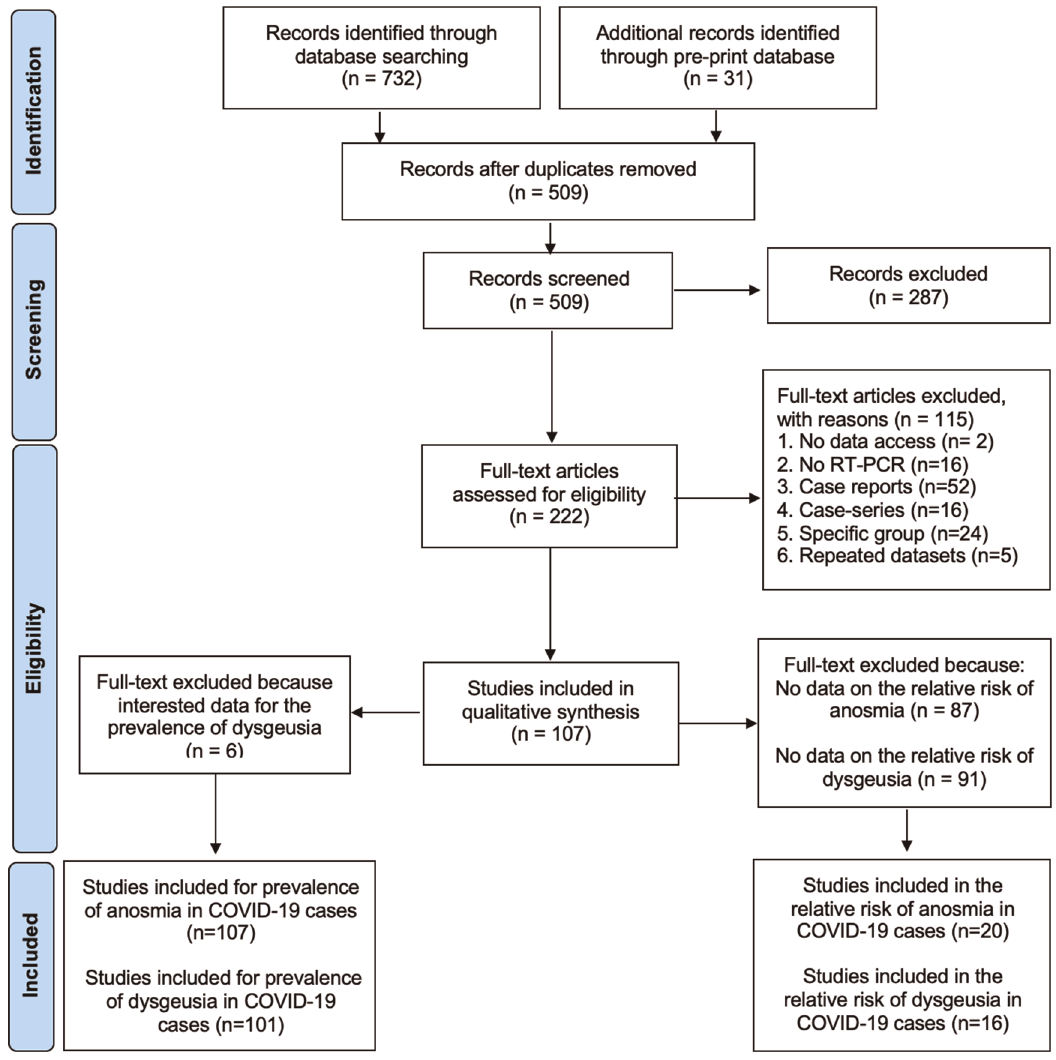
Figure 1. Flowchart of the result of literature search according to